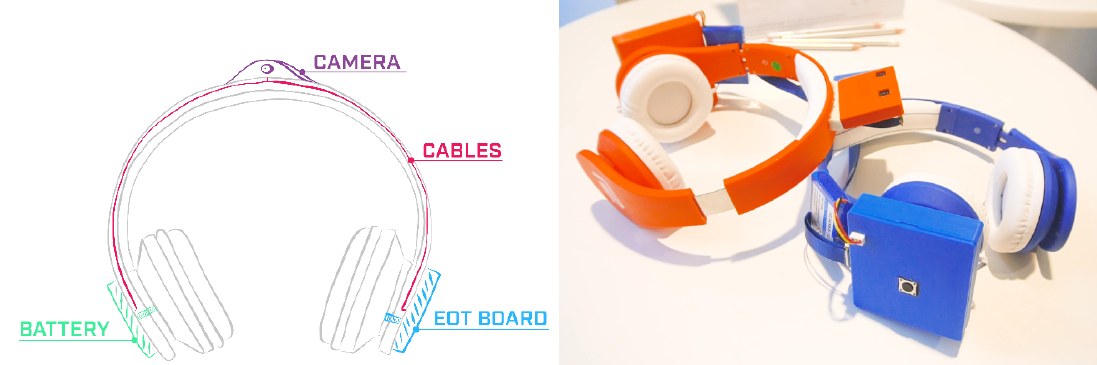
Figure 4. Museum Guide Headset concept draft and prototypes.